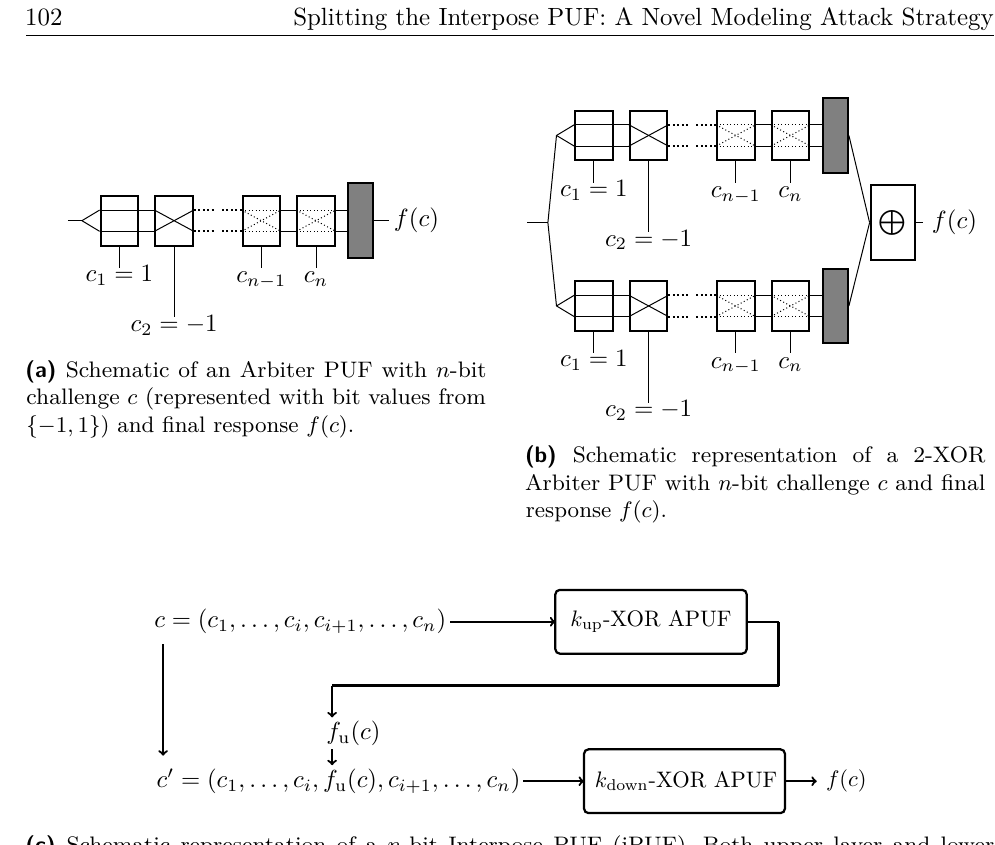
Figure 1: Schematics of Arbiter PUF, XOR Arbiter PUF, and Interpose